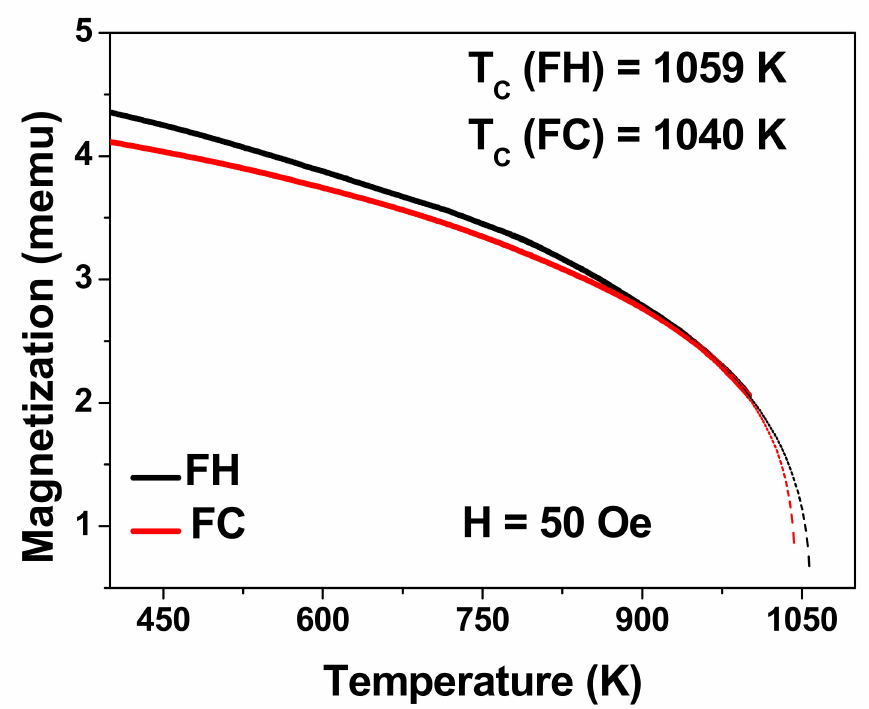
Figure 5. Temperature dependence of magnetization measured for Co 2 FeSi G-CMMWs at applied magnetic field (50 Oe) and temperature range from 400 to 1000 K. Dashed black and red lines refer to the T C fitting